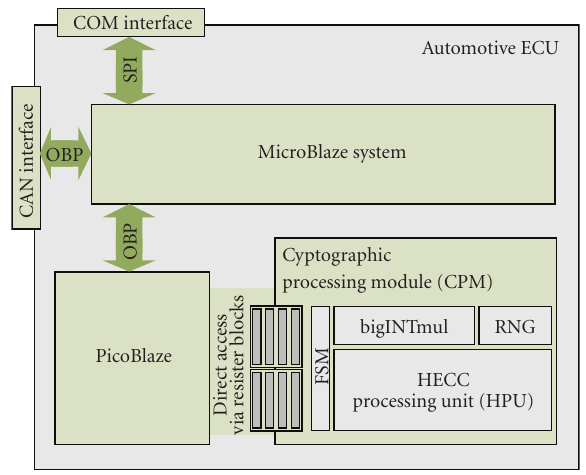
Figure 3: Overview of the system